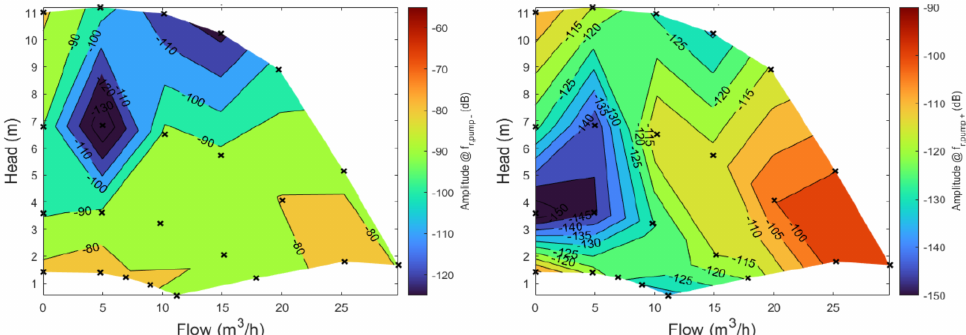
Figure 11. LoPoFIA for the fault indicators f r , pump − and f r , pump + for a pump with a cracked impeller